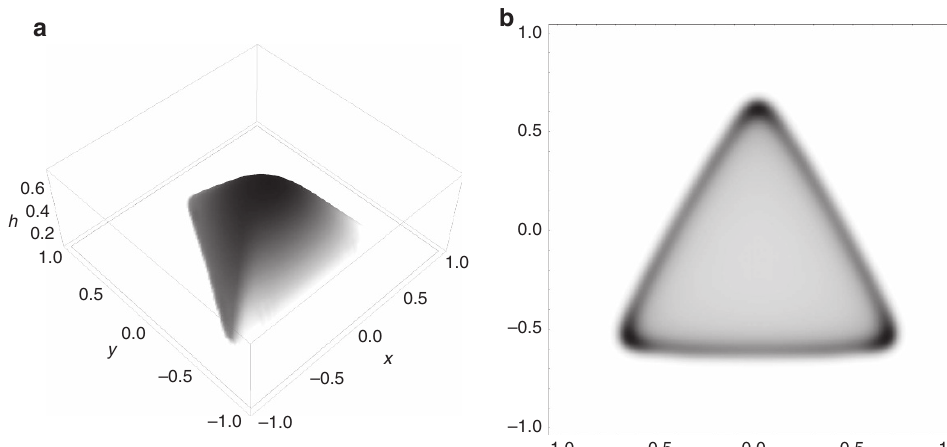
Figure 8 | Particle deposition in triangular drops. ( a ) Initial triangular state of the drop. ( b ) Resultant residue for C a ¼ 0.1, P e ¼ 10 3 , demonstrating accumulation at the corners as expected.